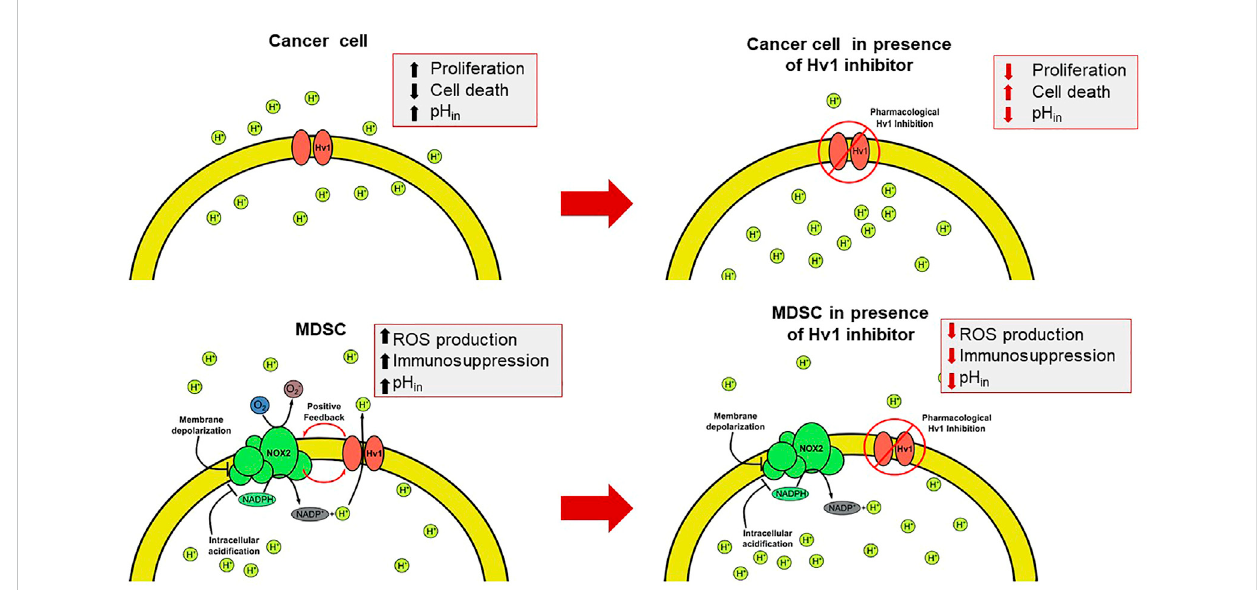
FIGURE 4 The intervention of the Hv1 function as a feasible therapeutic strategy for circumventing the TME. The presence of the Hv1 channel in cancer cells could be helpful to control the cytosolic pH. Once blocked, intracellular acidi fi cation could be harmful for tumors. On the other hand, in MDSC, Hv1 allows the sustained production of ROS, which give rise to the immunosuppressive function of MDSC. Then, the inhibition of Hv1 could diminish its immunosuppressive function. Both effects together could induce a decrease in tumor